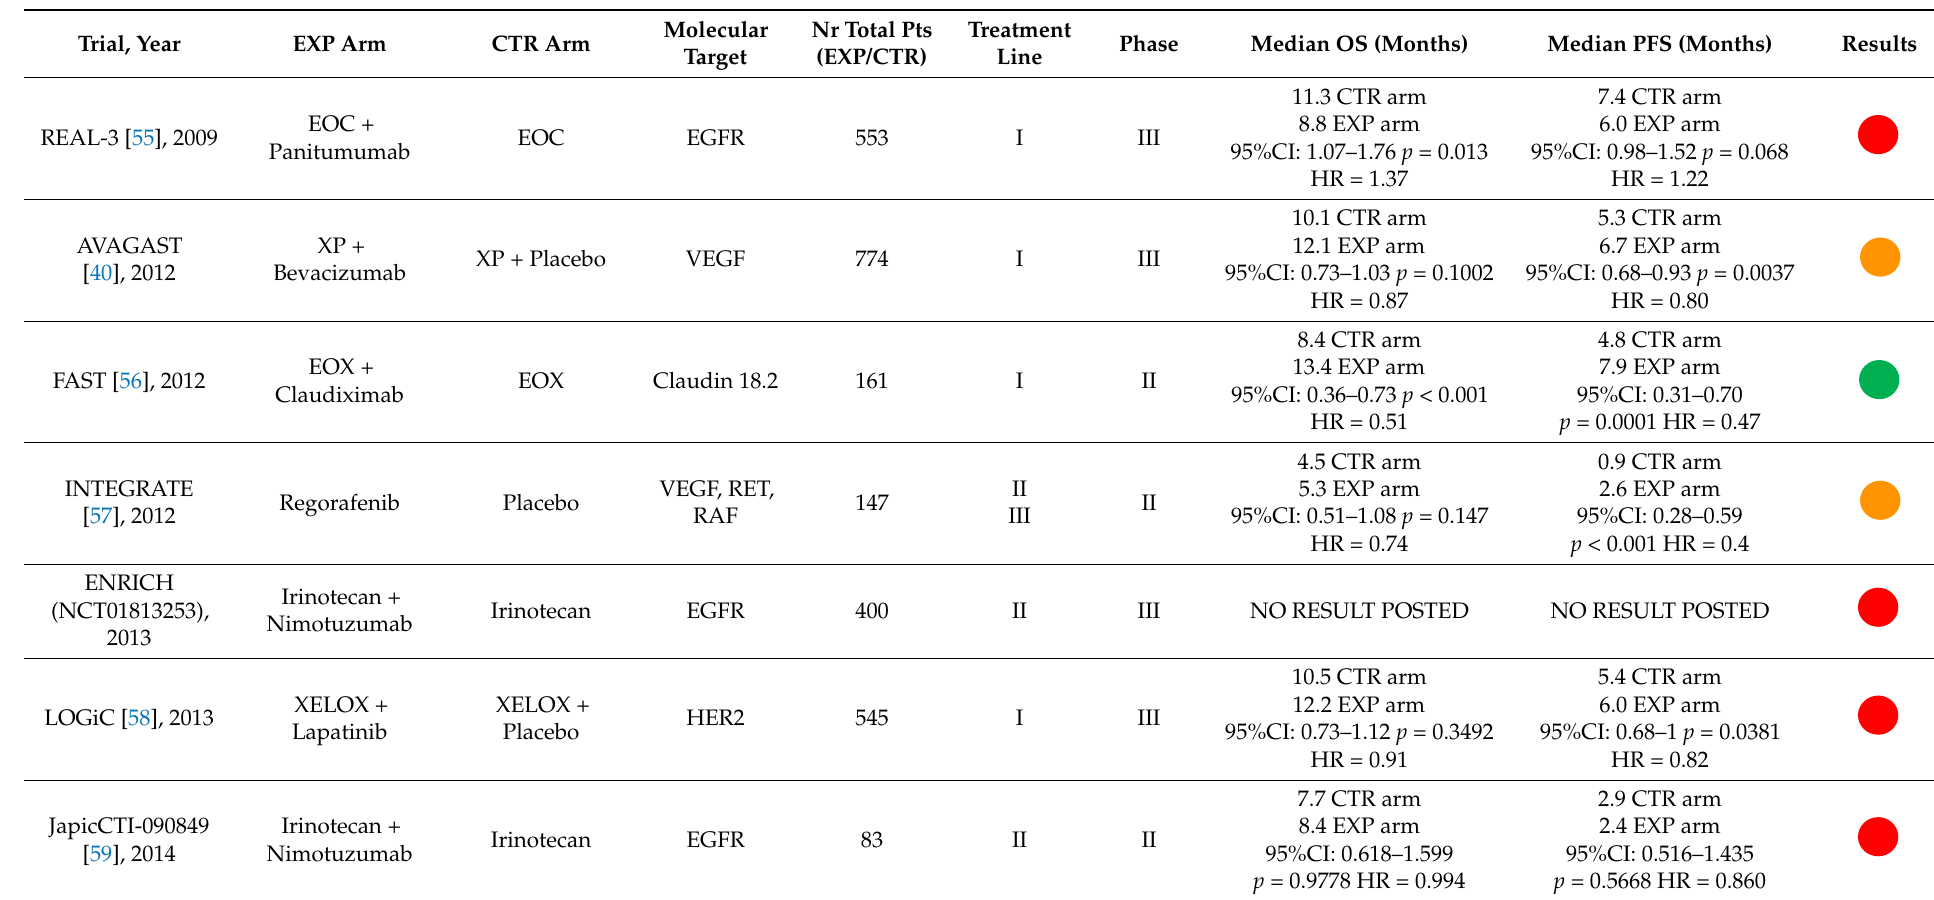
Table 1. Results of phase II and III trials. This table summarizes recent phase II and III RCTs investigating novel molecular agents’ survival outcomes. Unfortunately, most of these trials did not show any overall and progression free survival advantages as compared to conventional chemotherapy (red dot). Positive and partially positive studies have been pointed out with green and orange dot, respectively.